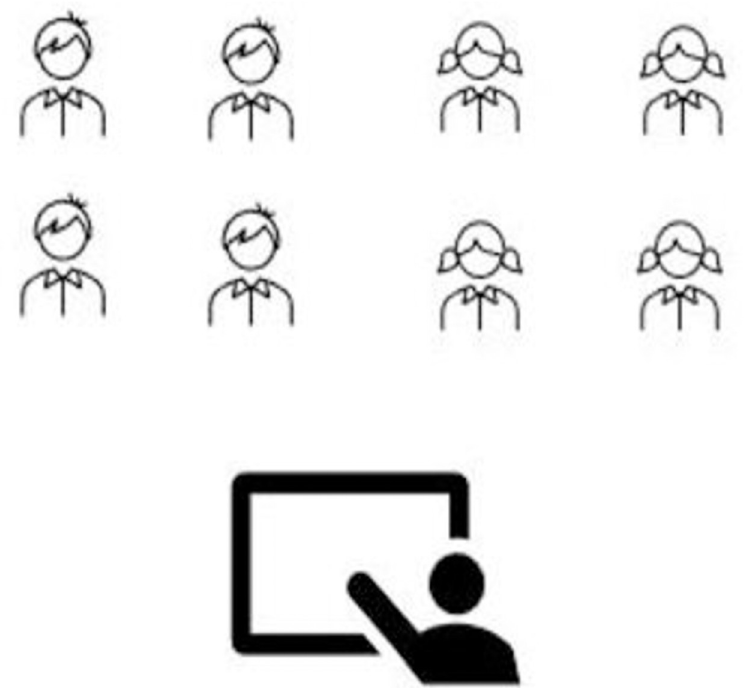
Fig 2. Mix-gender traditional learning men and women separated in the same classroom sitting on opposite